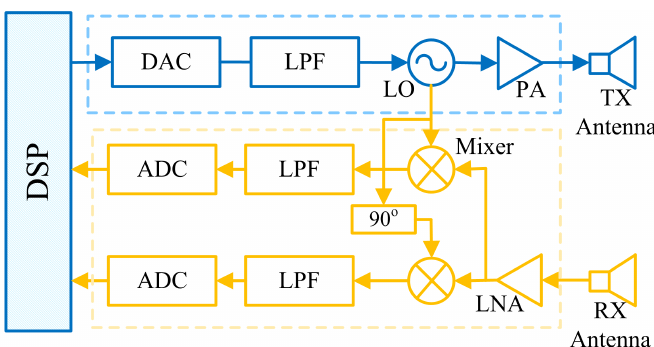
Figure 2. A high level block diagram of a next generation [5,31,32] radar